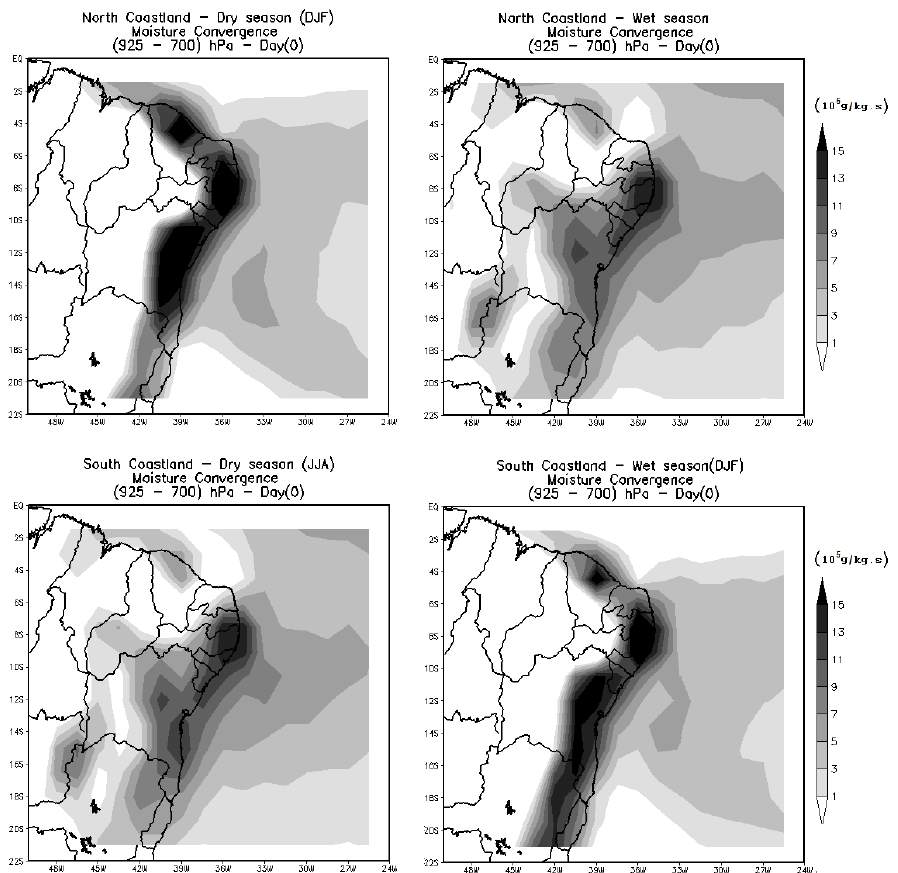
Fig. 5. Mean moisture convergence between the levels 925hPa and